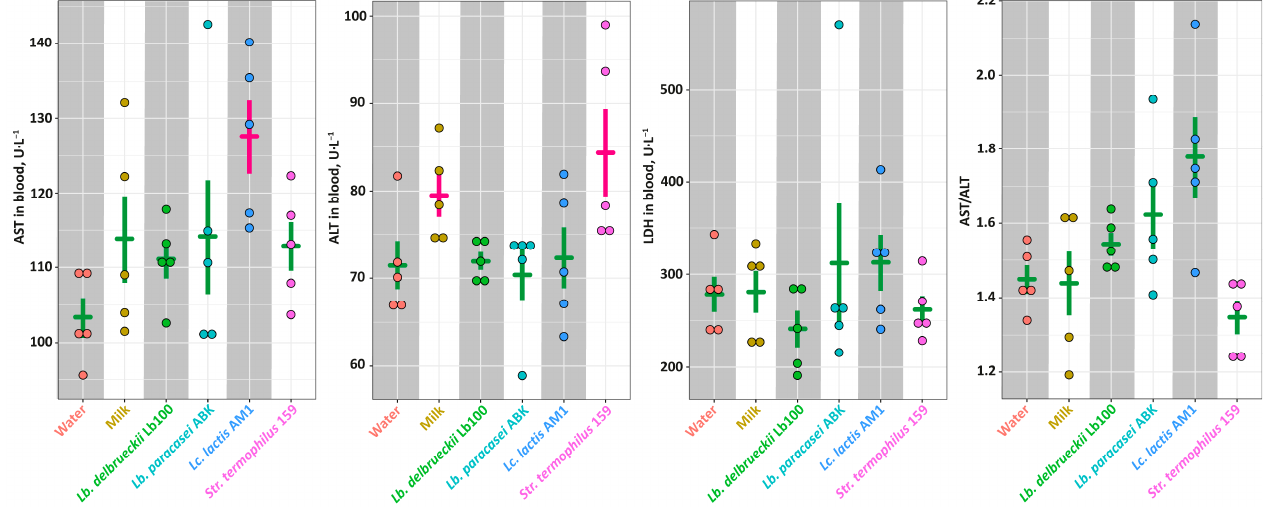
Figure 4. The markers of the liver health for studied animal groups. The bars (Mean ± SE) for the groups between which no statistically-significant differences were detected are depicted in the same color.